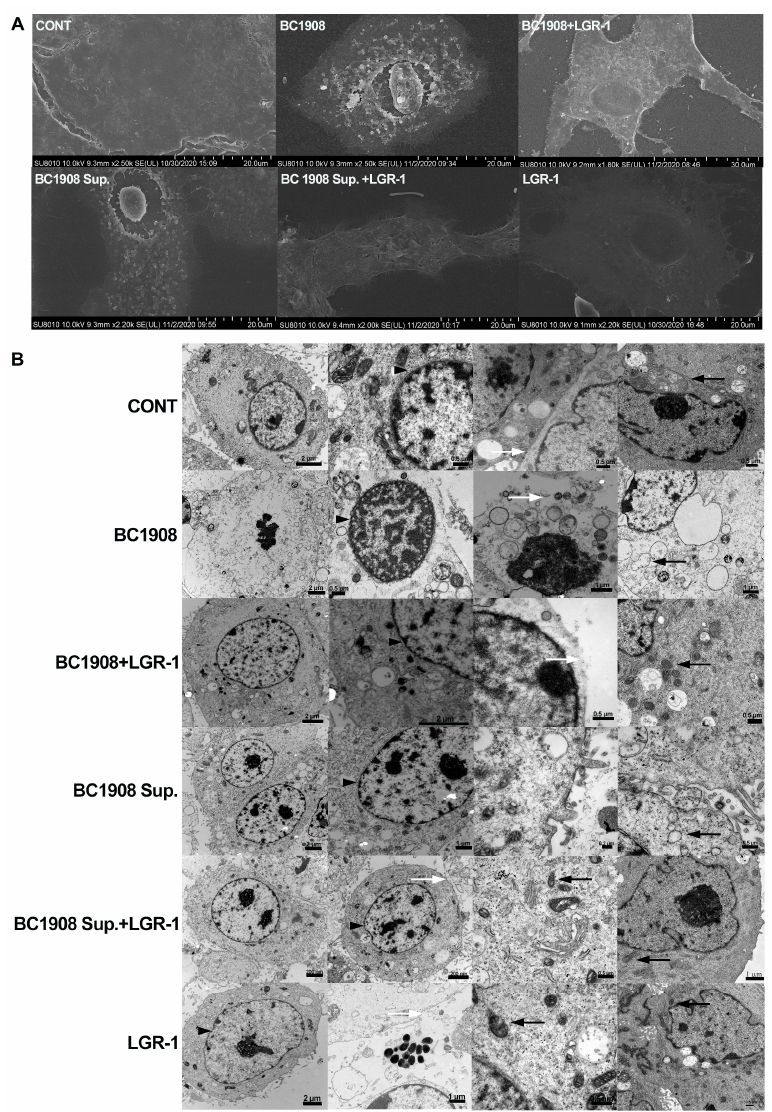
Figure 1. Scanning electron microscopy and transmission electron microscopy to observe LGR-1’s effects against B. cereus and BC1908 supernatant damage to the cell ultrastructure. ( A ) Scanning electron microscopy to observe the cell surface structure for different treatments. ( B ) Transmission electron microscopy to observe the changes in the cell ultrastructure in the different treatment groups. Black triangles indicate the nuclear membrane; white arrows indicate the cell membrane; black arrow refers to the